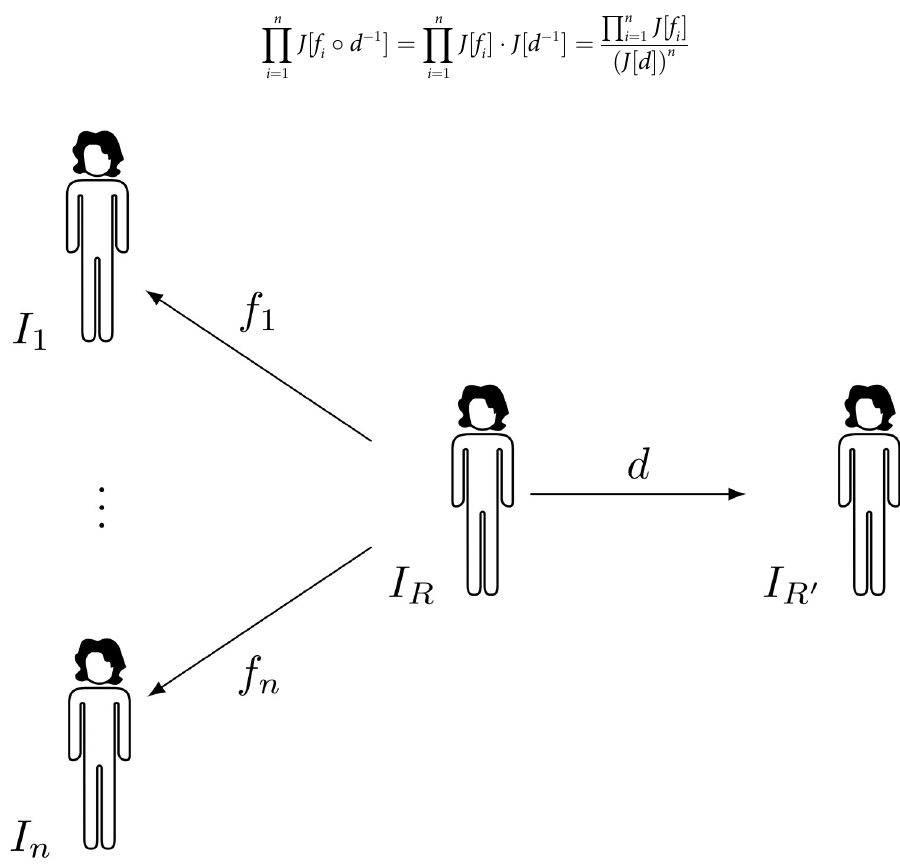
Fig 1. Diagram showing the transformations between images. Given a cohort of n subjects I 1 , ... , I n registered to the by the deformations f 1 , ... , f initial reference image I R deformation d whose Jacobian is the geometric mean of the Jacobians of f 1 , ... , f n .